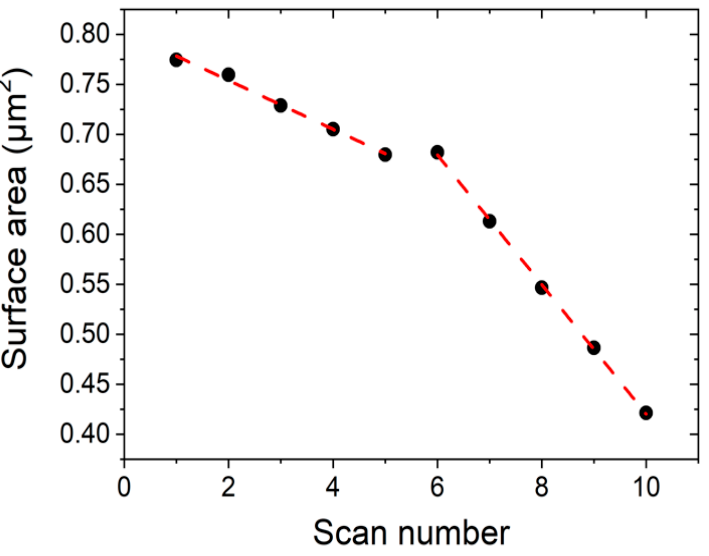
Figure 7. Surface area reduction during consecutive scans at RT using two different tip forces applied in the same scan regions. Scans 1–5 are taken at 1 nN, while scans 6–10 are taken at 3 nN.